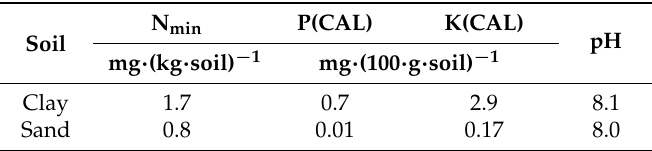
Table 4. Characteristics of soil substrates.